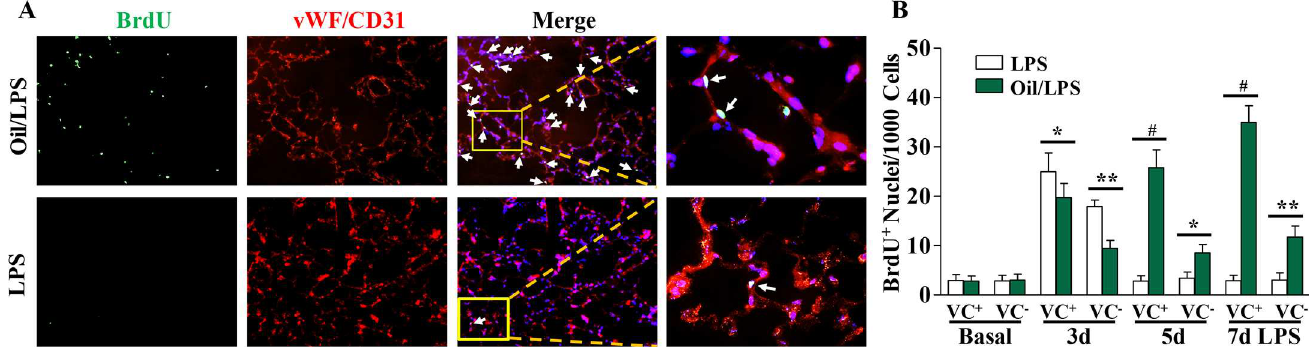
Fig 5. Cell proliferation in mouse lungs. ( A ) Representative micrographs of immunofluorescent staining. Lung tissues were collectedat indicated times post-LPS challenge,sectionedand immunostained with anti-BrdU (green)antibody.Lung ECs were immunostained with anti-vWF and CD31 antibodies(red). Nuclei were counterstained with DAPI (blue). Arrows indicate proliferating EC. Scale bar, 50 μ m. ( B ) Quantification of BrdU-positive ECs (vWF + or CD31 + ) and non-ECs (vWF - or CD31 - ) in mouse lungs. Data are expressedas mean ± SD (n = 4/group). * , P < 0.05; ** , P < 0.01; #, P < 0.001. VC + , vWF + or CD31 + ECs; VC - , vWF - or CD31 - non-ECs.